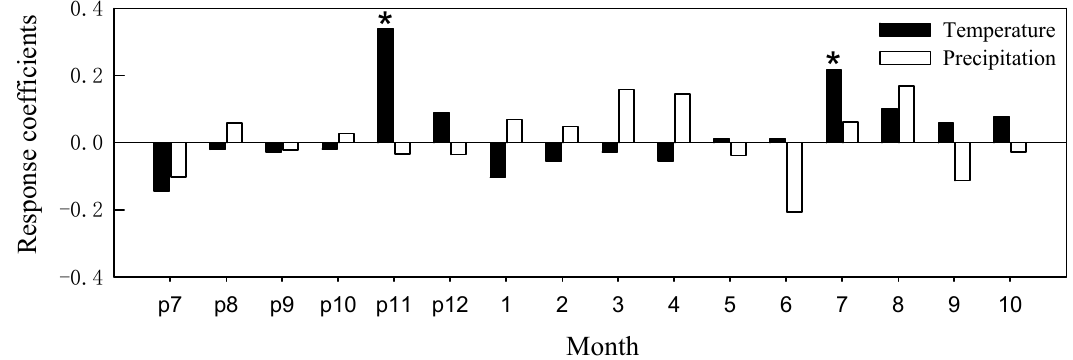
Figure 6. Response function analysis between the PC#1 of four chronologies and climate variables for the common period 1961–2010.